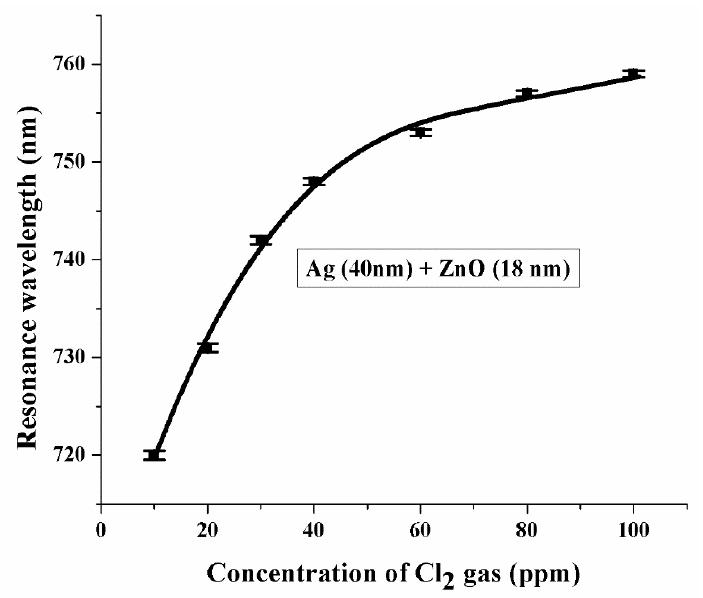
Figure 5. Variation of resonance wavelength as a function of concentration of chlorine